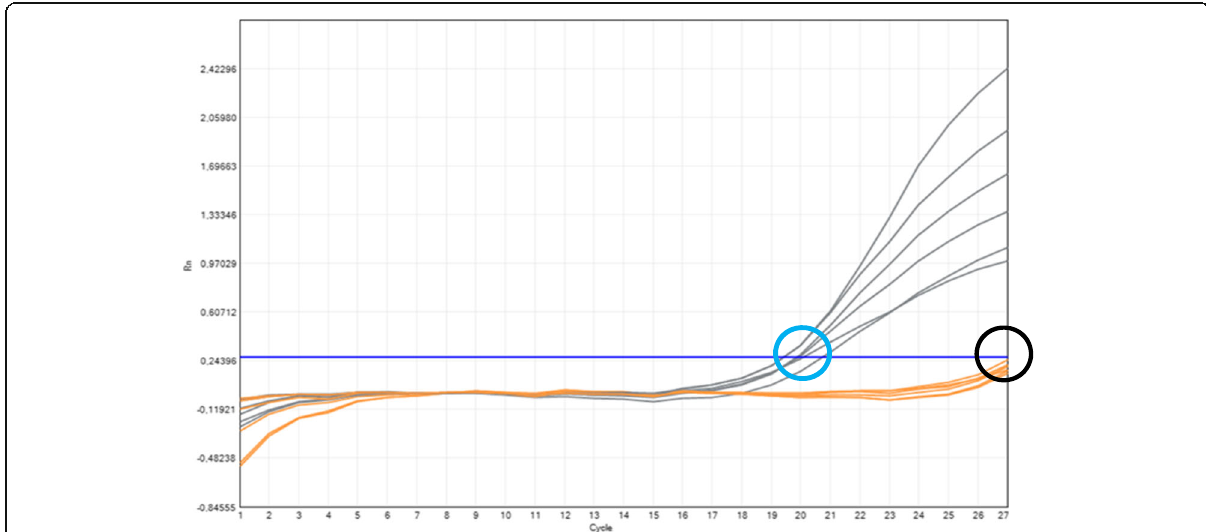
Fig. 3 Behavior of non-carrier samples in the allele specific multiplex-PCR scanning 14 CFTR gene mutations. Wild type ( gray ) and mutant ( orange ) curves. The blue circle points out the Ct zone of the wild type PCR, the black circle points out the unspecific amplification of mutant PCR